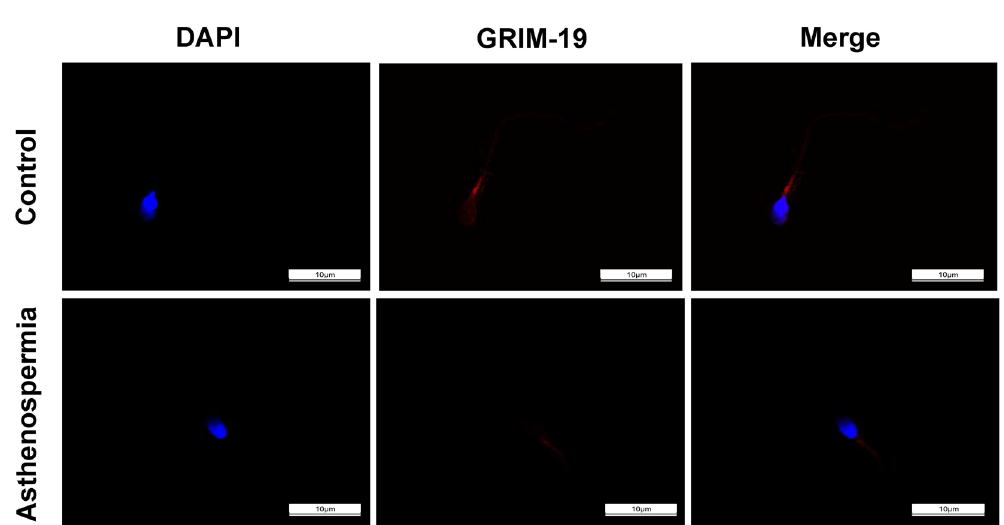
Table 1. Clinical characteristics of study participants. The data were expressed as means ± standard deviations (SD), p < 0.05, statistically significant difference.